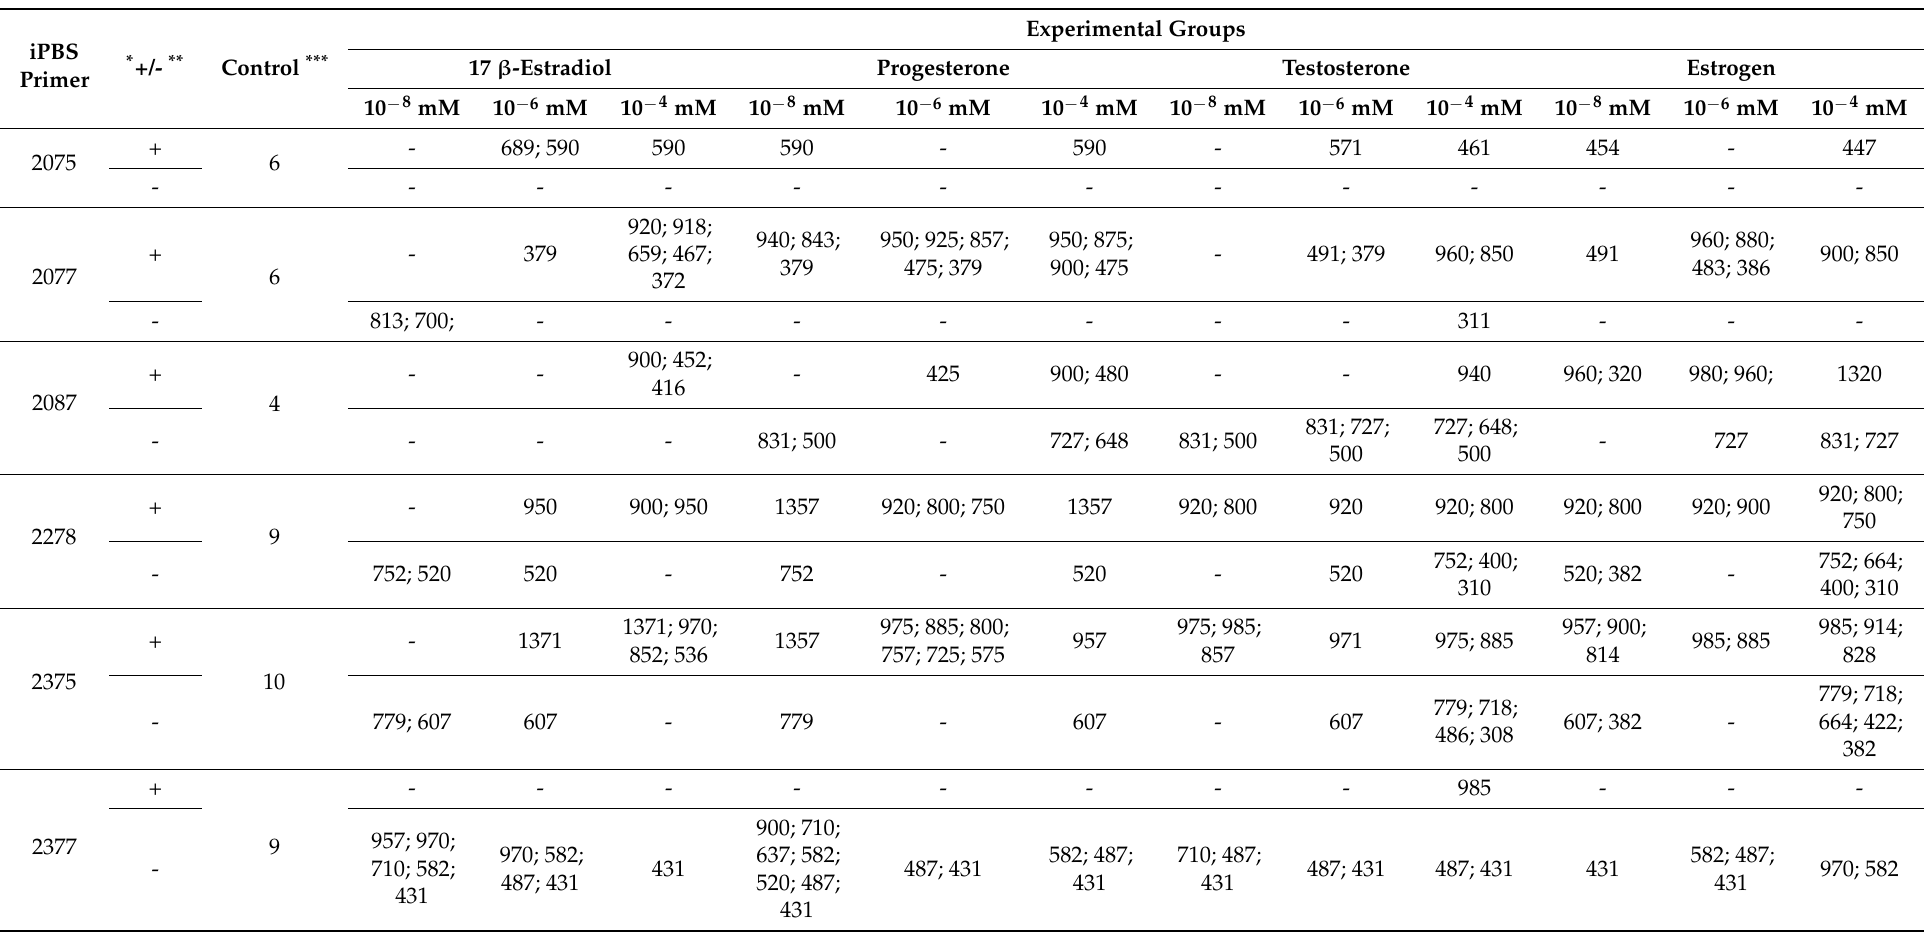
Table 1. Molecular sizes (bp) of present/absent bands in iPBS profiles after application of different MSHs and different concentrations in treated Phaseolus vulgaris L. under tissue culture